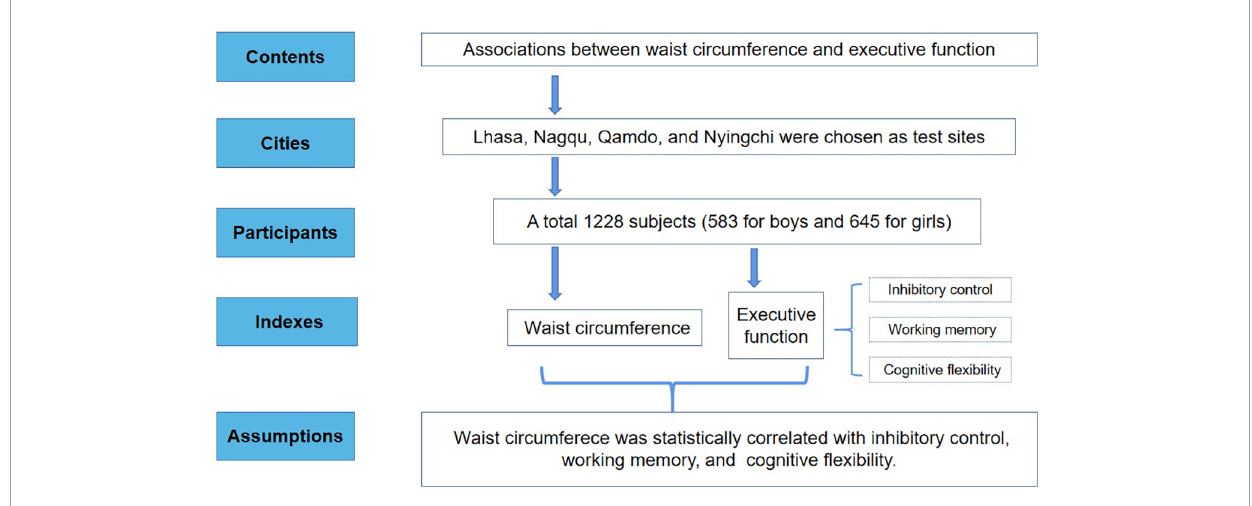
FIGURE1 Flowchart of the study design.